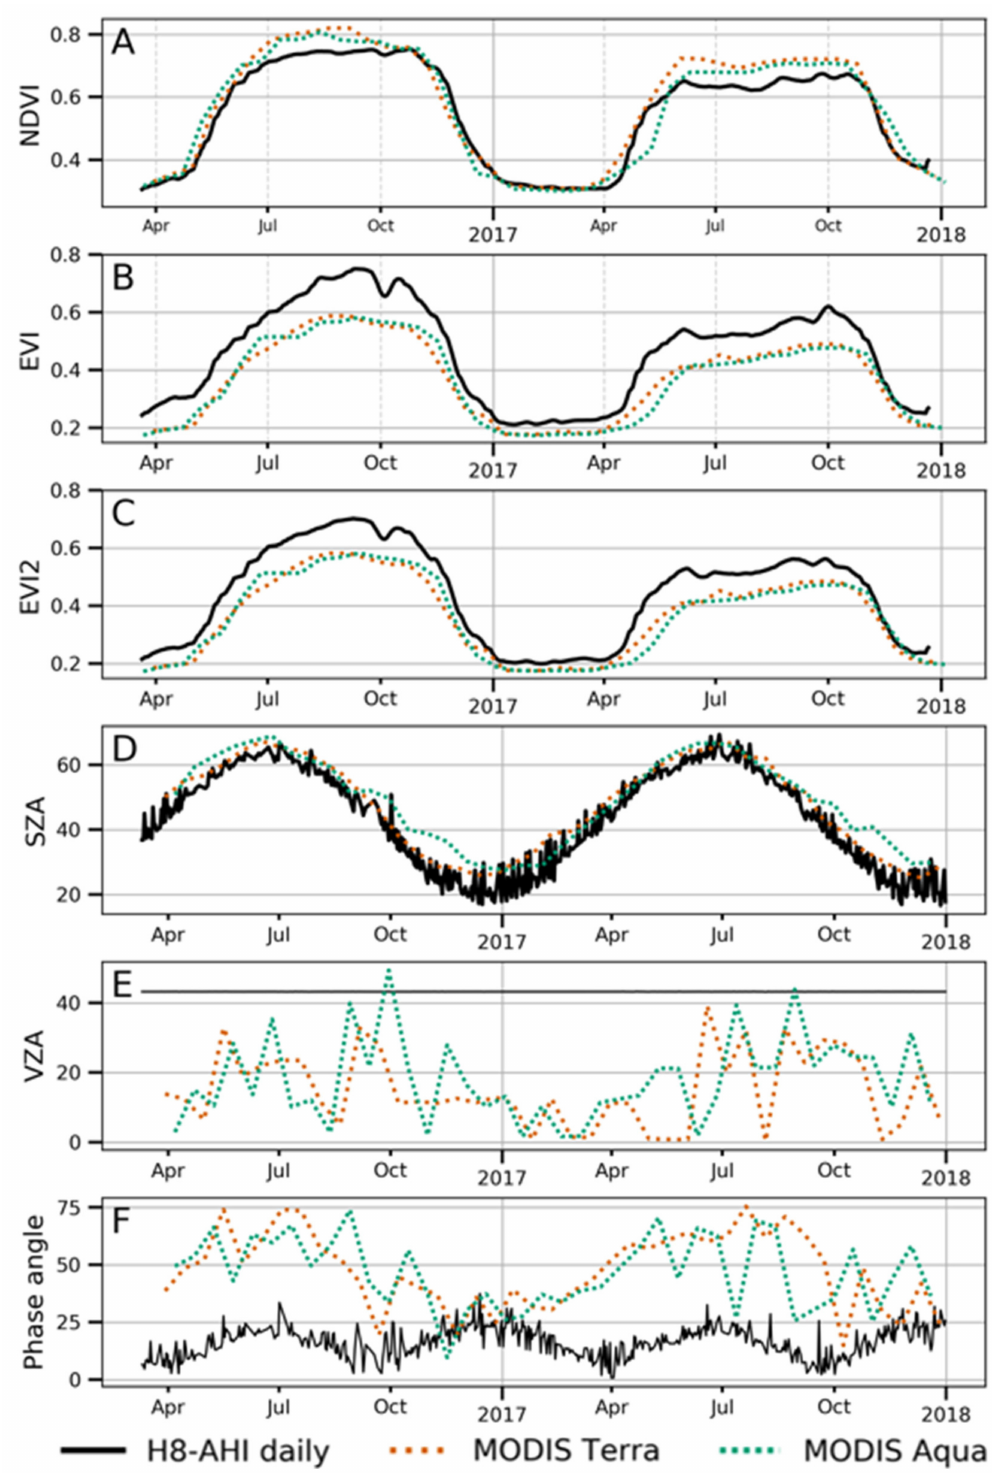
Figure 10. Comparison of smoothed, solar noon daily composited ( A ) AHI NDVI, ( B ) AHI EVI, and ( C ) AHI EVI2, with respective standard MODIS 16-day NDVI, EVI, EVI2 over the 2016 and 2017 growing seasons at the Redesdale grassland site. Associated MODIS and AHI observation geometries are shown for ( D ) solar zenith angle (SZA), ( E ) view zenith angle (VZA), and ( F ) phase angle. The two major cross-sensor observation geometry di ff erences were (1) the more oblique sensor view zenith angle of AHI and (2) the smaller phase angles of AHI, relative to MODIS